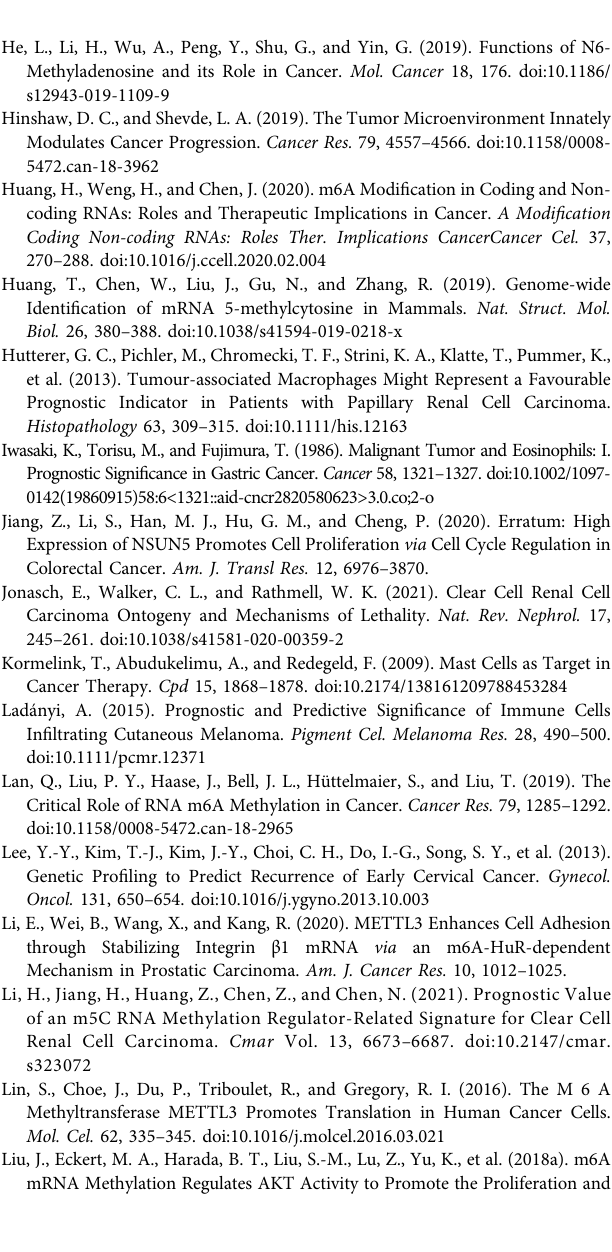
Supplementary Table S1 | Different expression of 35 RNA methylation regulators. Supplementary Table S2 | Multivariate Cox regression on the 24 selected regulatory factors. Supplementary Table S3 | Five prognostic